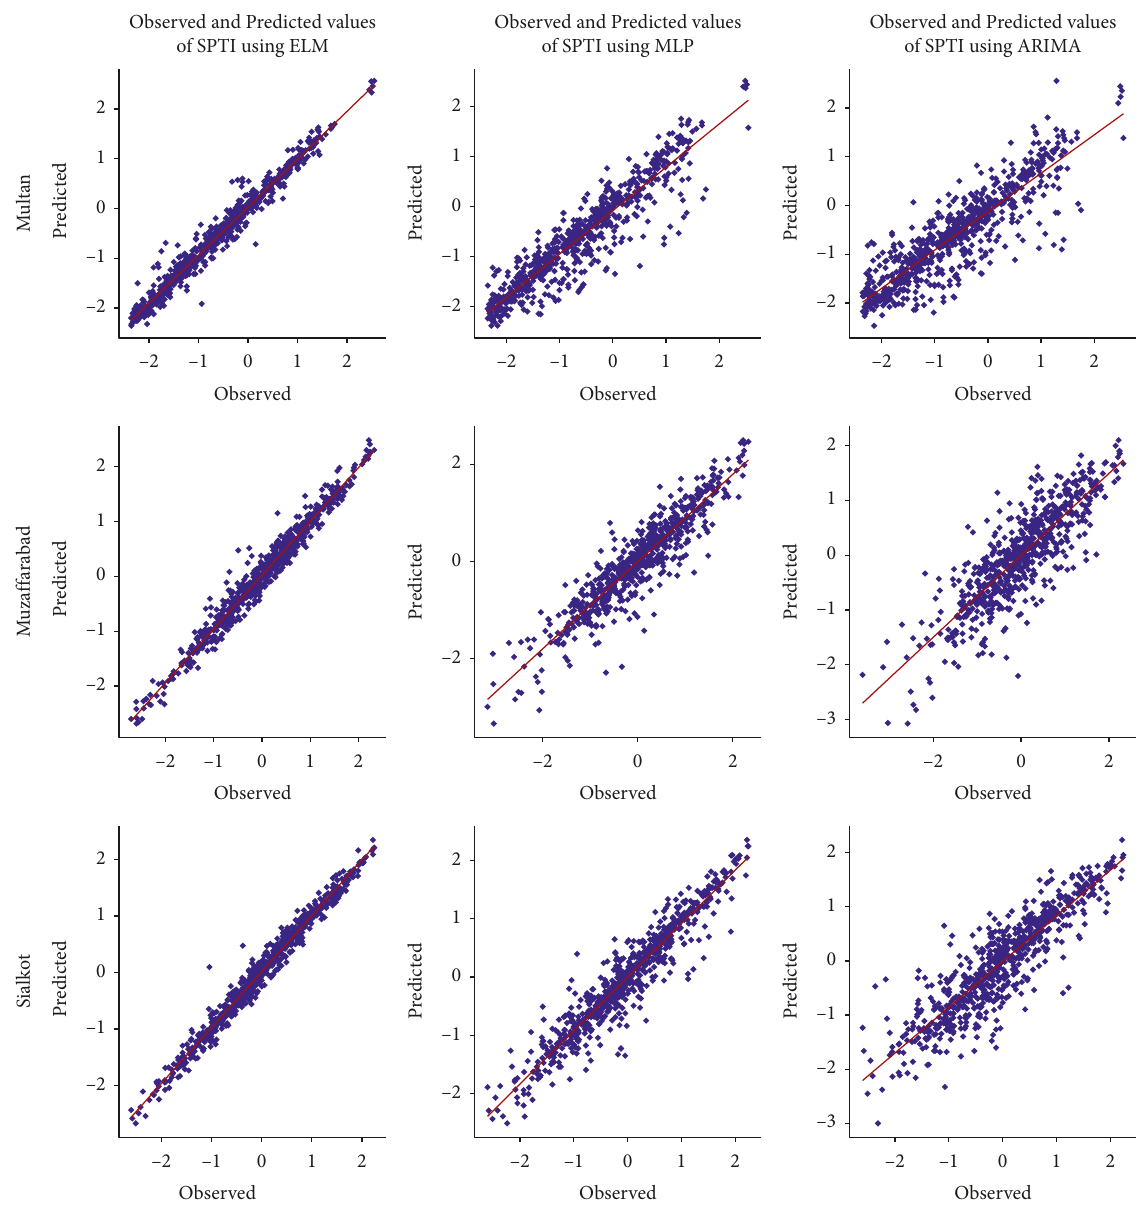
Figure 10: Scatter plots of the observed and predicted values of SPTI using ELM, MLP, and ARIMA at Muzaffarabad, Multan, and Sialkot stations for the training